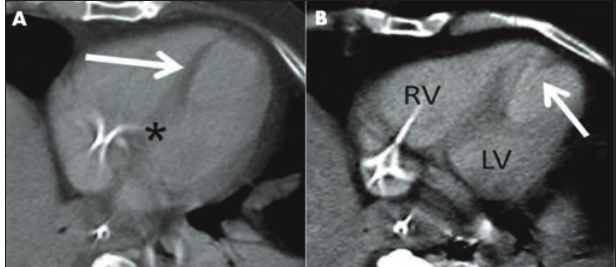
Fig. 3. Post contrast chest CT scan in a 67-year-old man performed to rule out pulmonary embolism or pneumonia. (a) Transaxial CT image at the level of the interventricular septum demonstrates hypoperfusion of the mid-distal septum (arrow) in comparison with the basal septum (*). (b)Transaxial CT image at the level of the inferior septum demonstrates a large defect in the muscular portion of the septum (arrow). (LV = left ventricle; RV = right